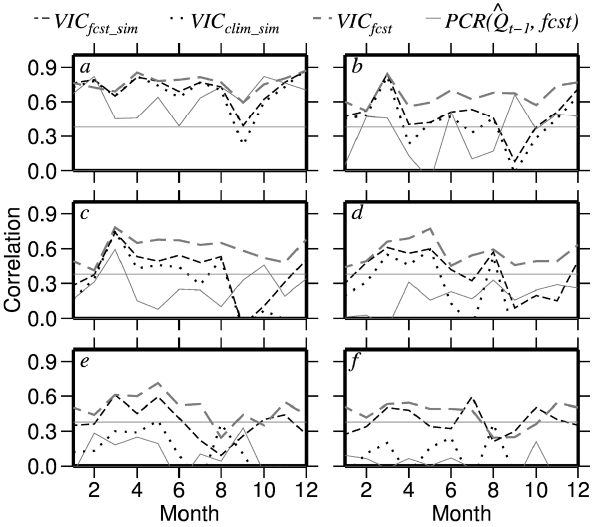
Fig. 5. Mean Square Skill Score comparison of estimated stream- flow at lead times 1 (a) to 6 (f)